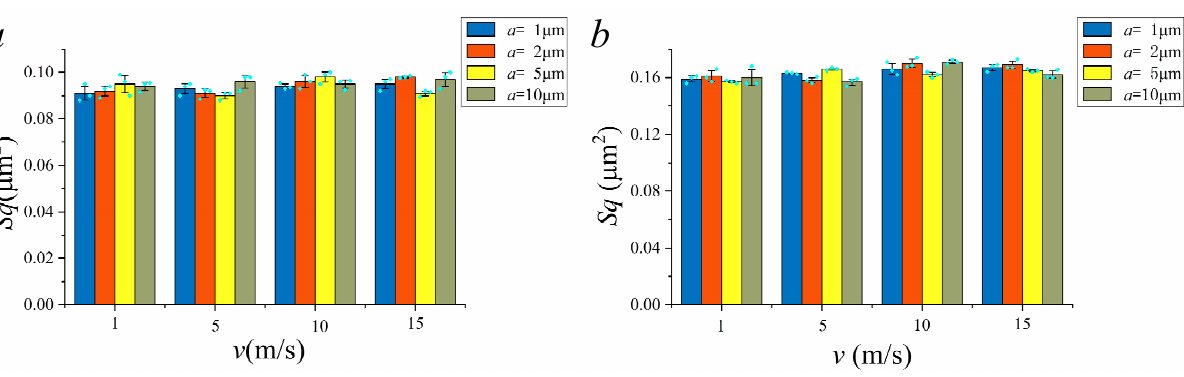
Figure 6. Digital combination model. ( a ) Reconstructed topographies of the HFB; ( b ) reconstructed topographies of LFB.